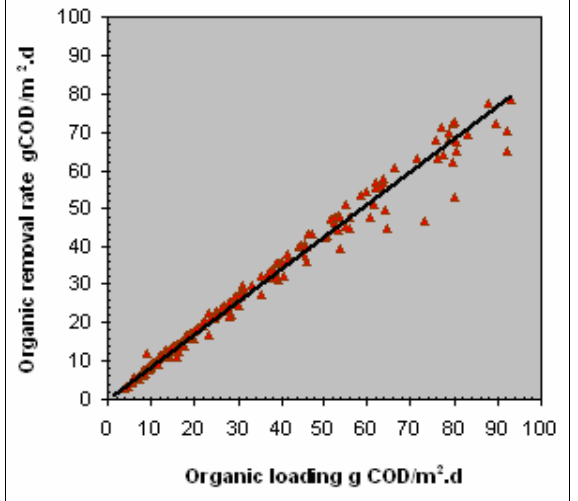
Figure 17: Effect of total applied organic loading on organic removal rate (organic loading up to 100 gCOD/m 2 .d).